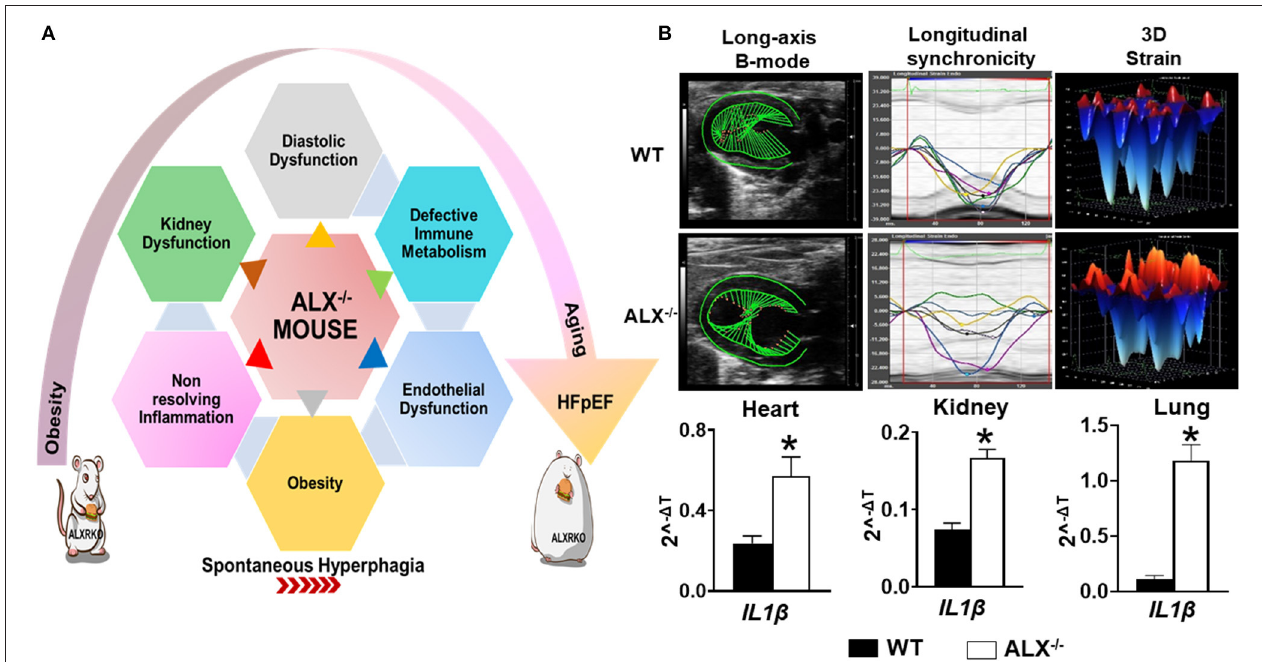
FIGURE 2 | Resolvin D1 and lipoxin receptor-deficient mice (FPR2/ALXKO) complement the criteria of HFpEF with profound age-associated endothelial dysfunction and inflammation in the spleen, heart, and kidneys with signs of chronic inflammation. (A) Left panel indicates the heterogeneous, multidimensional, and multiorgan metabolic defects that contribute to HFpEF. (B) Right panel indicates the dysfunction of the resolution receptor FPR2/ALX in mice that develops spontaneous obesity with diastolic dysfunction along with limited changes in systolic function when obesity is superimposed on aging as signs of preserved ejection fraction. Suboptimal inflammation indicated with profound activation of IL1 β gene expression in the heart, kidneys, and lungs in FPR2/ALXKO mice exemplifies the age-associated cardiac strain dysfunction, myocardium dissynchronicity, and amplified inflammation. * p < 0.05 compared to control WT